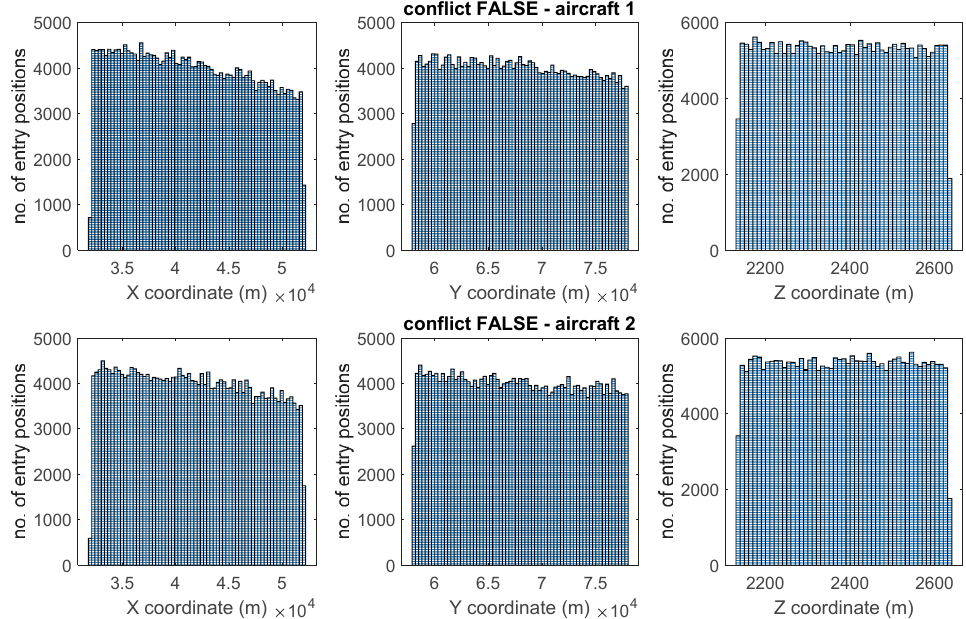
Figure 7. Entry positions distribution of nonconflicting pairs of aircraft.